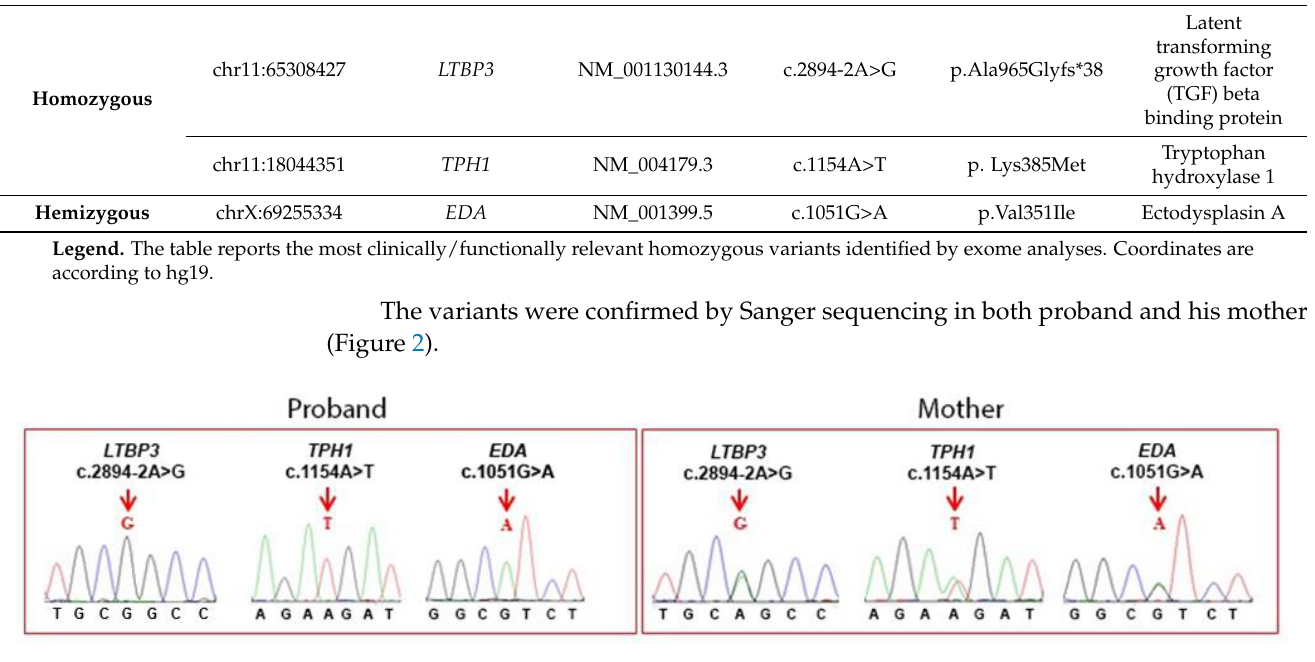
Figure 2. Sanger validation and variants segregation. The figure shows Sanger sequence chromatograms of the selected genes in the proband and his mother. Nucleotide numbers are derived from the coding sequence of LTBP3 (GenBank accession NM_001130144.2), TPH1 (GenBank accession NM_004179) and EDA (GenBank accession NM_001399).